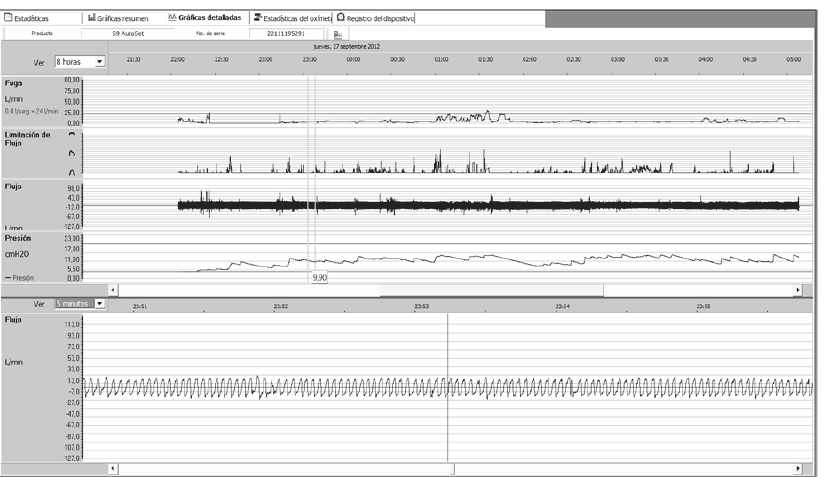
Figure 2: One-night CPAP data using ResScan Software. The pressure, flow, and leak channels can be appreciated (limit of leakage